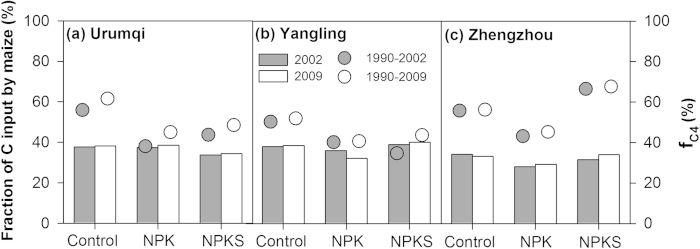
Fractions of carbon input by maize during 1990–2002 (solid circles) and 1990–2009 (hollow circle), and maize’s contribution to SOC (fC4, 0–40 cm) in 2002 (grey bars) and 2009 (white bars) under different fertilization treatments.